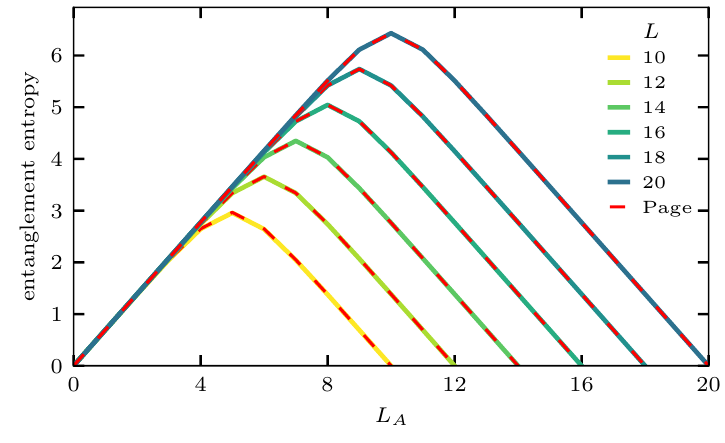
Figure 4: Entanglement entropy as a function of subsystem size L the unitary (1) for different system sizes L = 10...20. For each curve, a different realization of the random circuit was generated and the mean over 50 eigenstates was taken. The variance over eigenstates is very small (of the order of 10 − 4 and smaller). The dashed red lines show the expected entanglement entropy for infinite temperature pure states [ 56 ]